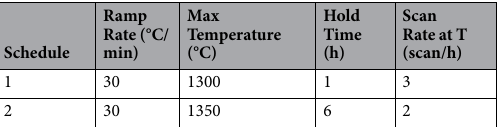
Table 2. HTXRD schedules used to study phase conversion of Ce-zirconolite